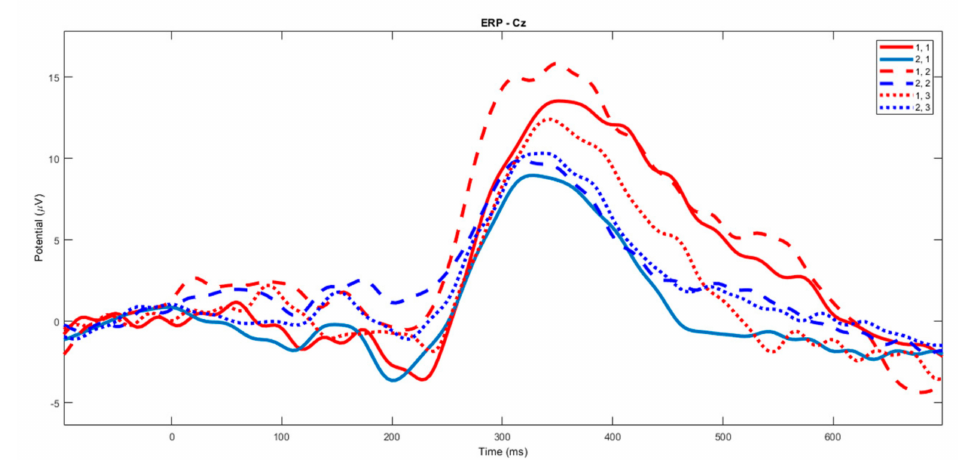
Figure 8. The grand average of the laser-evoked potentials on the left hand stimulation. The control group’s basal condition (1,1), slow finger tapping (1,2) and fast finger tapping (1,3); the fibromyalgia (FM) group’s basal condition (2,1), slow finger tapping (2,2) and fast finger tapping (2,3) (see also Figure 1).